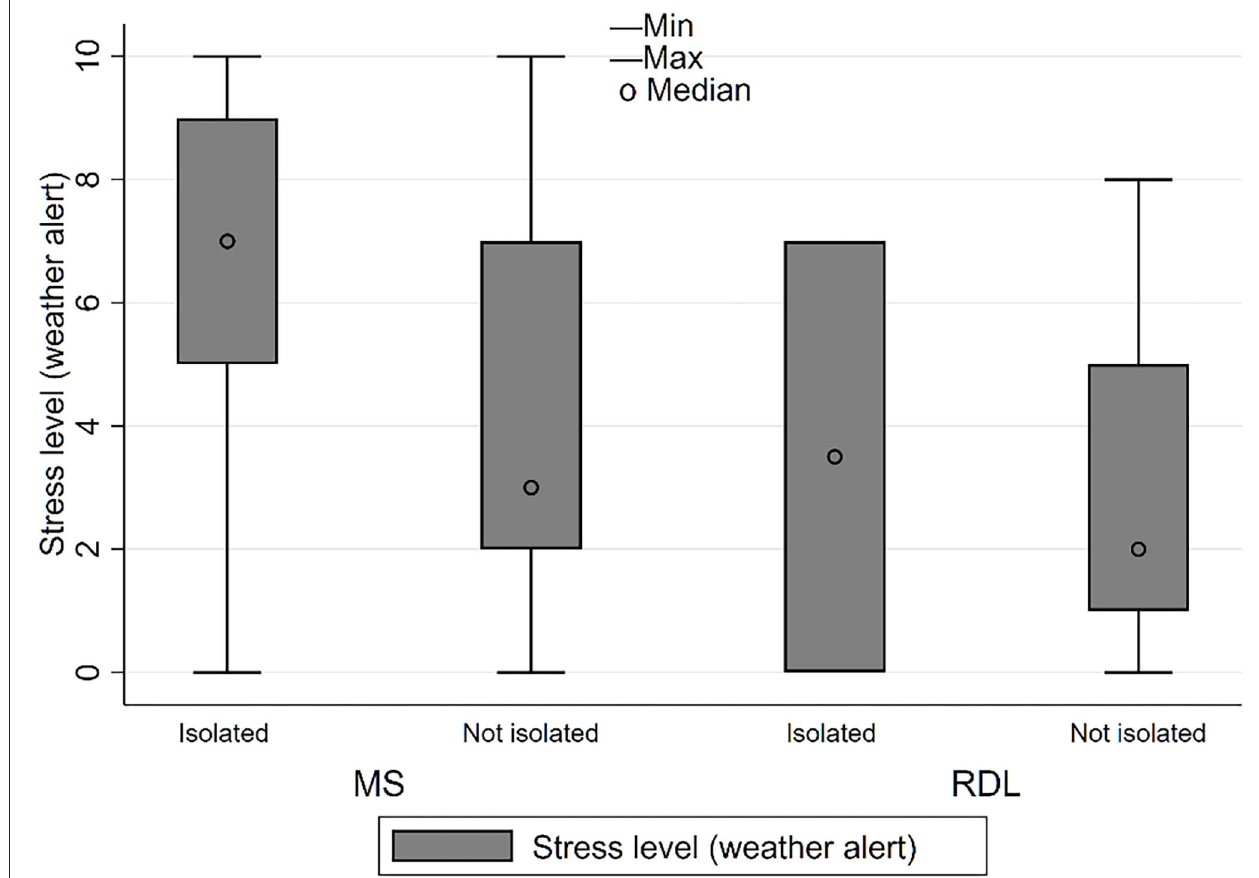
FIGURE 5 | Stress level according to the respondent’s local social